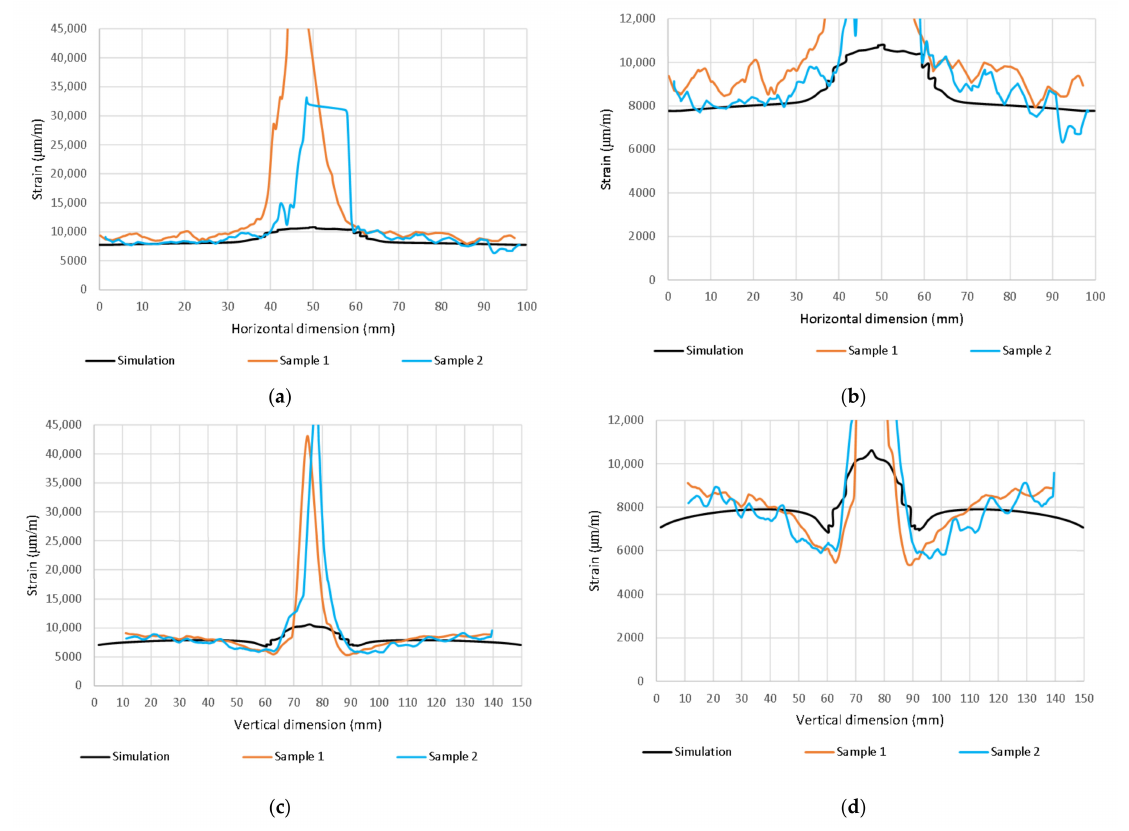
Figure 18. Max. principal strain distribution ( µ m/m) at load 110 kN; ( a ) Horizontal path—scale 1; ( b ) Horizontal path—scale 2; ( c ) Vertical path—scale 1; ( d ) Vertical path—scale